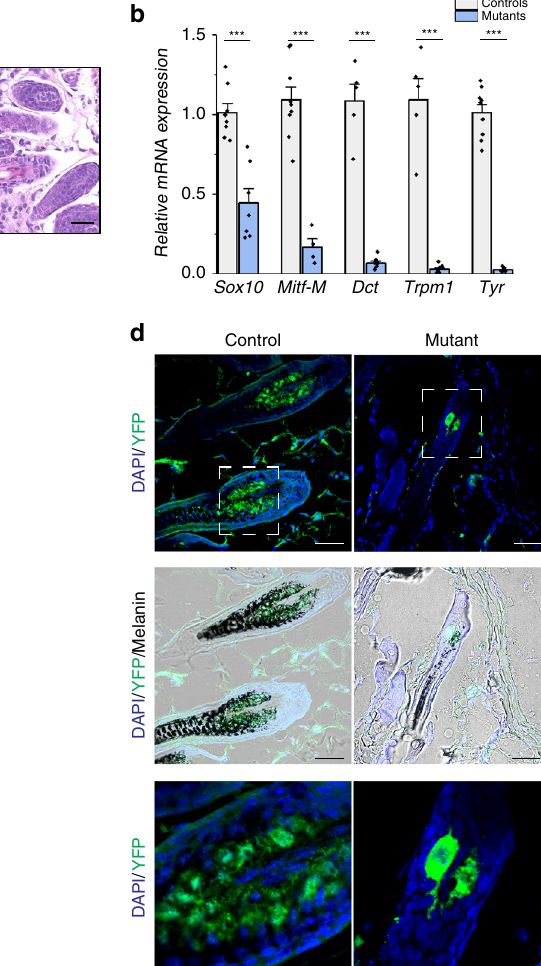
Fig. 2 NC Adar1 deletion leads to reduced number of melanocytes in the skin of mutants at P4. a Paraf fi n skin sections from control and HtPA-Cre; Adar1 fl / fl mutant mice stained with hematoxylin and eosin (H/E). Black arrowheads indicate presence of melanin in controls. Scale bar: 25 μ m. b Relative expression level of melanocyte-expressed genes in skin of control (gray) and mutant (blue) mice ( n = 5 or 8 controls and n = 4, 7 or 9 mutants depending on tested genes) analyzed by RT-qPCR. The relative abundance values of each amplicon were normalized to the internal control β -actin, and expression level of mutants and controls represented relative to controls. All data represent mean ± SEM, asterisks represent p value: ***p < 0.001 determined using t test. c Number (%) of follicles containing YFP-positive cells in the skin of control and mutant mice. Representative regions showing YFP (green) cells in follicles and quanti fi cation are presented in controls (gray) and mutants (blue). Statistical differences between the groups ( n = 3 independent controls and mutants) were determined using t test (asterisks represent p value: ***p < 0.001). Scale bar: 50 μ m. d Morphology and functionality of remaining YFP- positive cells (melanocytes) in follicles of control and mutant mice. Melanin synthesis (black) is shown on white light images. Bottom panels represent higher magni fi cations of upper panels (Scale bars: 50 and 15 μ m, respectively). In ( c ) and ( d ) counterstaining with DAPI (blue) is shown to identify structures. Careful analysis of the few remaining YFP-positive cells in mutants skin showed them to be enlarged and able to produce melanin, suggesting that when still present, mutant melanocytes can retain at least part of their functionality. For ( b ) and ( c ), source data are provided as a source data fi